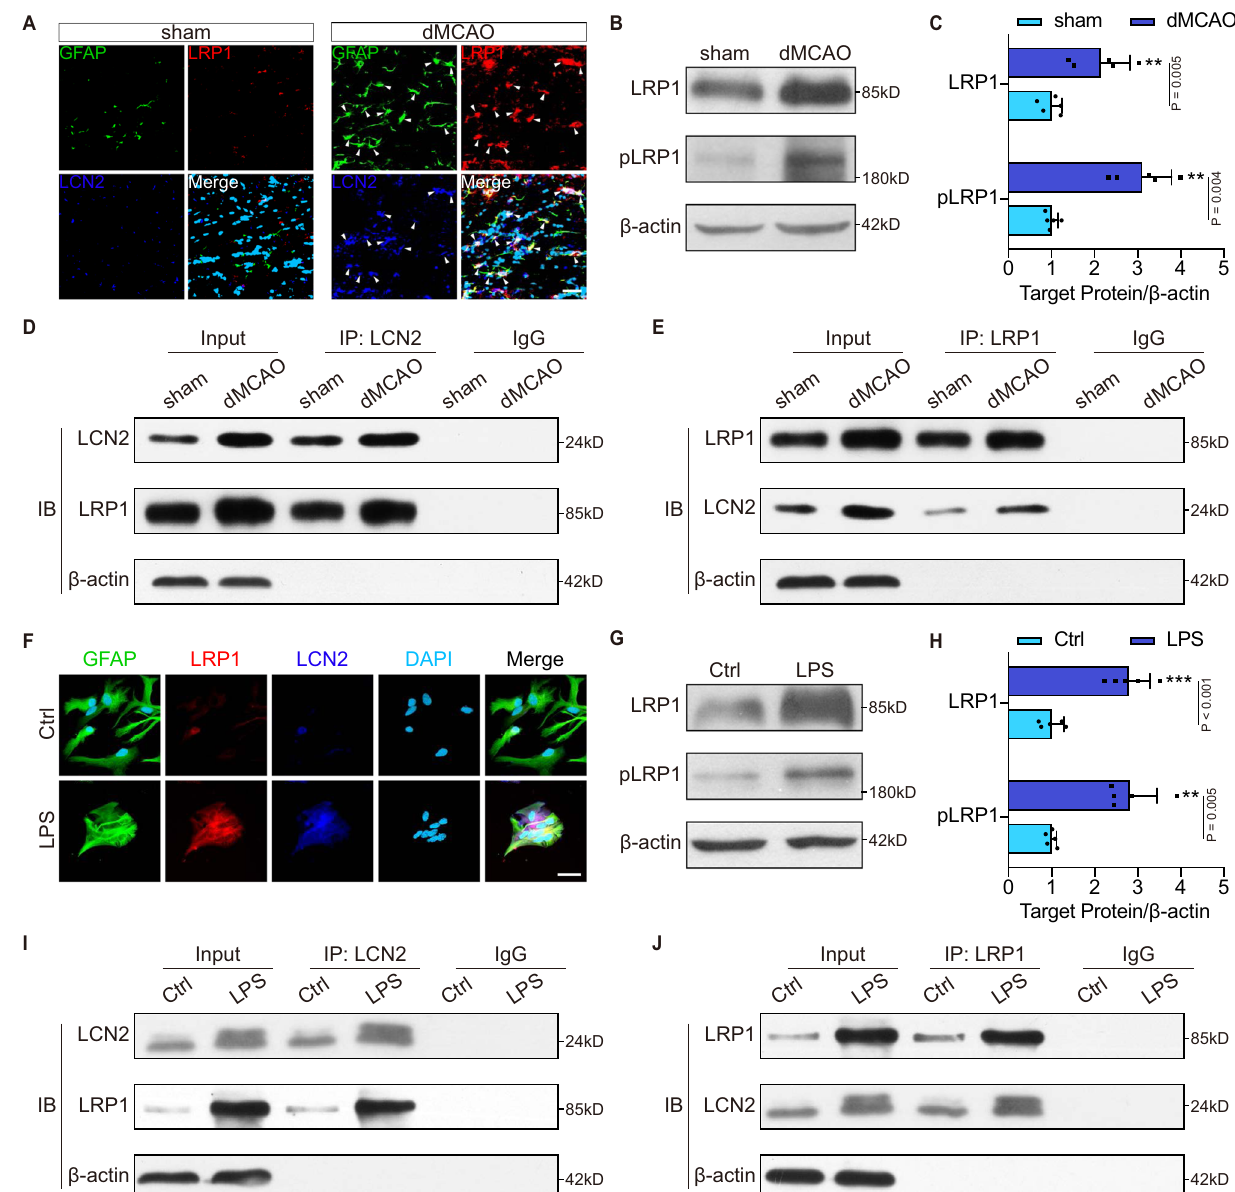
Fig. 8 LCN2 interacts with LRP1 in reactive astrocytes. A Immuno fl uorescence showing the expression of GFAP (green), LRP1 (red), LCN2 (blue) and DAPI (cyan) in vivo. White arrows point to the co-localization of LRP1 and LCN2. Scale bar, 20 μ m. B , C Immunoblotting and quantitative analysis for LRP1 and pLRP1 in sham and dMCAO mice ( n = 5 mice; mean ± S.D.; ** P < 0.01 vs. sham; paired t -test). D , E Immunoassay of the ipsilateral CC lysates. After immunoprecipitation with anti-LCN2 or anti-LRP1 antibodies respectively, the immunoprecipitates were analyzed by immunoblotting with anti-LCN2 and anti-LRP1 antibodies ( n = 5 mice). F Representative immunocytochemistry images showing co-locolization of LRP1 (red) and LCN2 (blue) in astrocytes (GFAP, green) after LPS treatment. Scale bar, 20 μ m. G , H Immunoblotting and quantitative analysis for LRP1 and pLRP1 in vitro ( n = 5 independent primary cell cultures; mean ± S.D.; ** P < 0.01, *** P < 0.001 vs. Ctrl; paired t -test). I , J Astrocyte lysates of control and LPS groups were immunoprecipitated with anti-LCN2 or anti-LRP1 antibodies, and then analyzed by immunoblotting with anti-LCN2 and anti-LRP1 ( n = 5 independent primary cell cultures). For immunoblotting experiments, protein samples derived from the same experiment and gels/blots were processed in parallel. Source data are provided as a Source Data fi le. with inducible LRP1 signaling, are responsible for the transfor- mation of reactive astrocytes into phagocytic cells. These pha- to white matter damage (Supplementary Fig. 13). Therefore, our study may provide a meaningful target for direct inhibition of astrocyte reactivity and phagocytic transformation for the future treatment of neurological disorders involving secondary degen- eration of white matter or other demyelinating diseases. NATURE COMMUNICATIONS| (2022) 13:1134